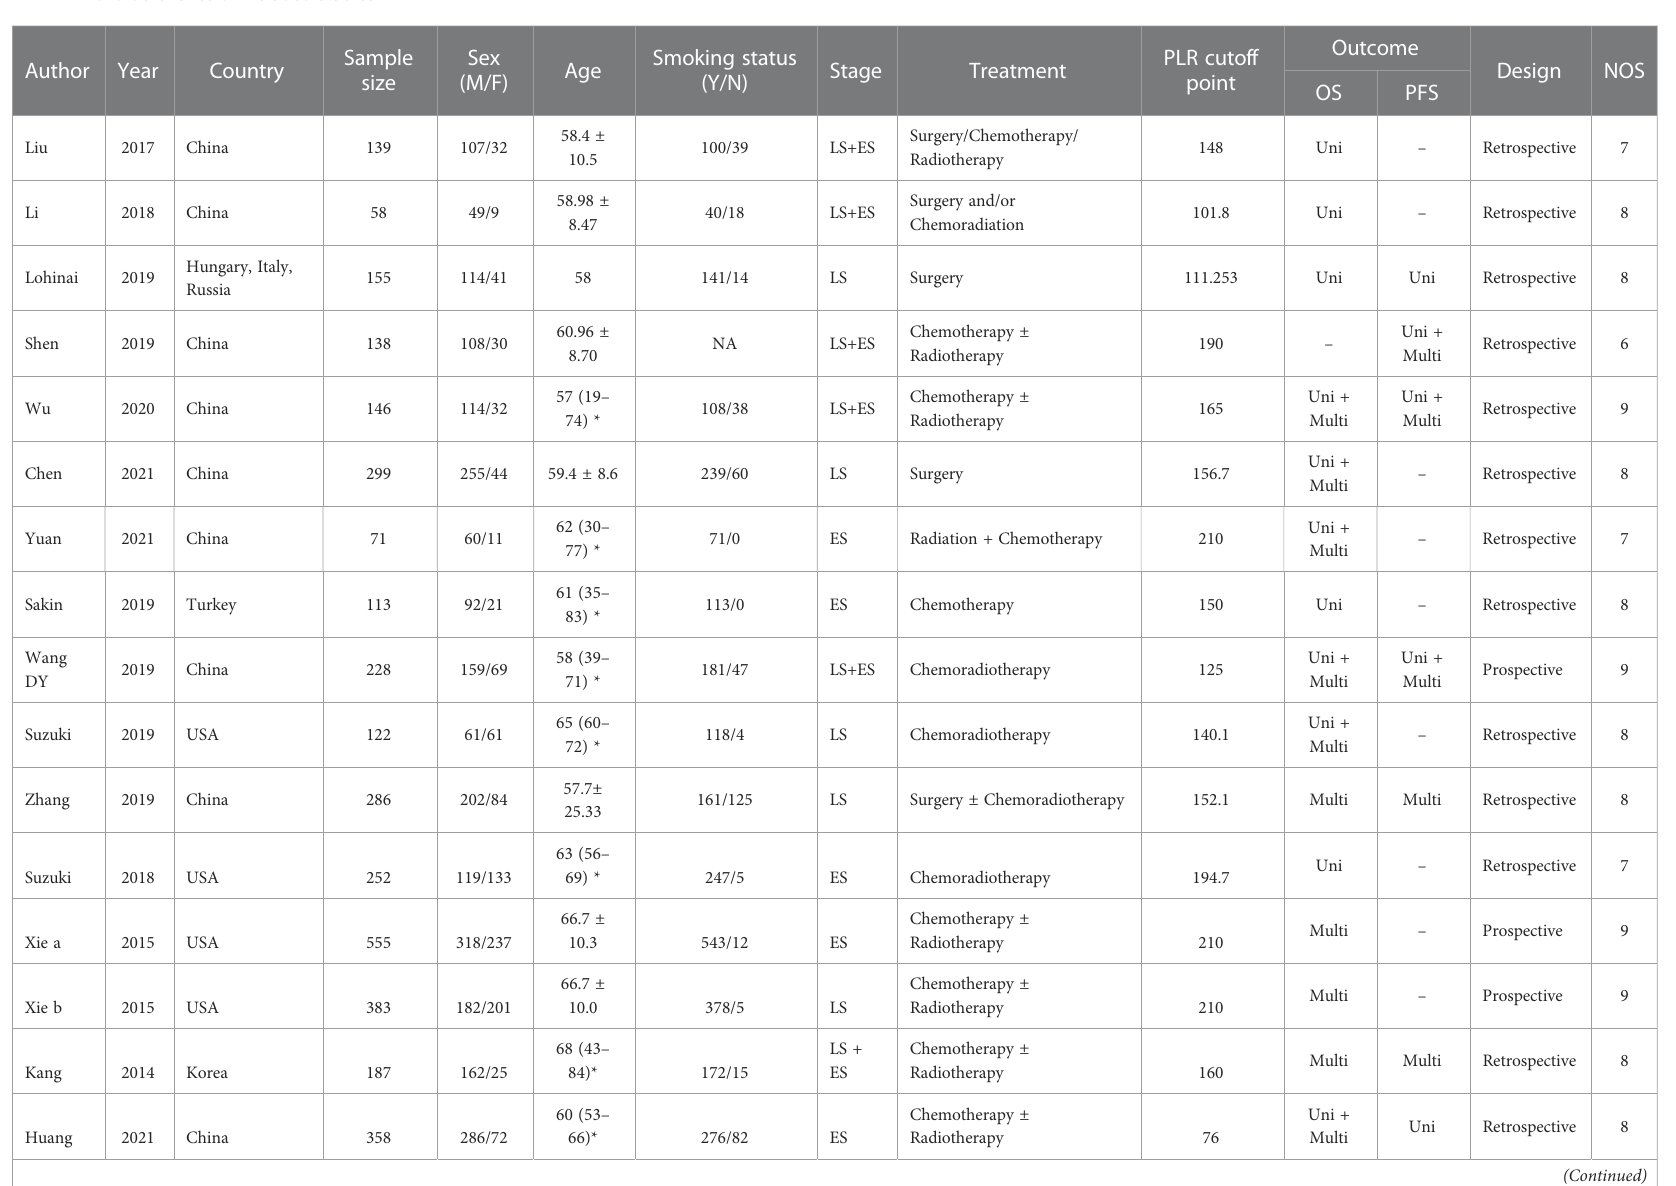
TABLE 1 Characteristics of included